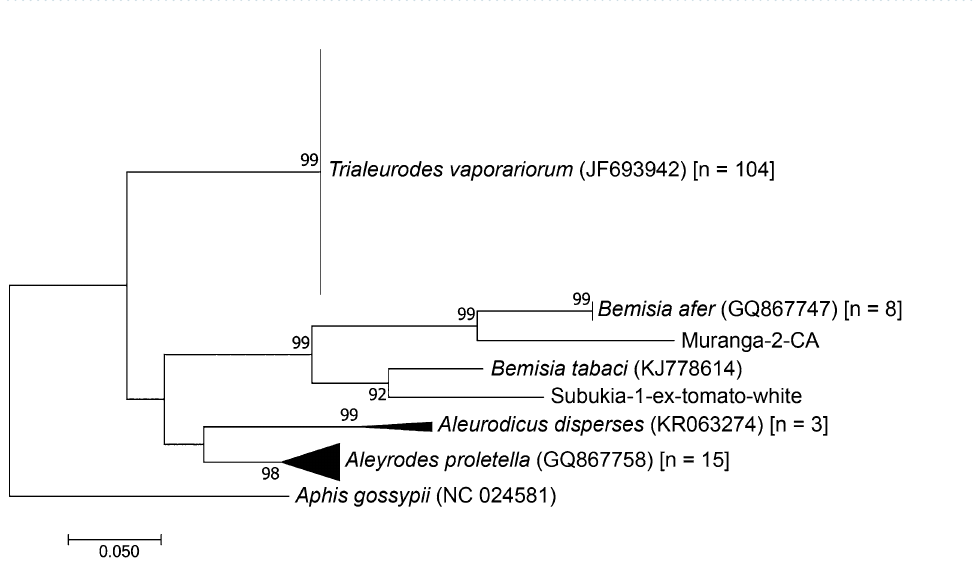
Figure 3. Maximum-likelihood tree based on a 650 bp alignment of 132 sequences of the 16S ribosomal RNA ( rrna) gene using the whitefly specific from whitefly samples collected from Kenya and reference whitefly sequences available in GenBank (n = 5), with Aphis gossypii as an outgroup. The number of sequences obtained in this study is indicated in square brackets. Branchsupport was based on 1000 bootstrap